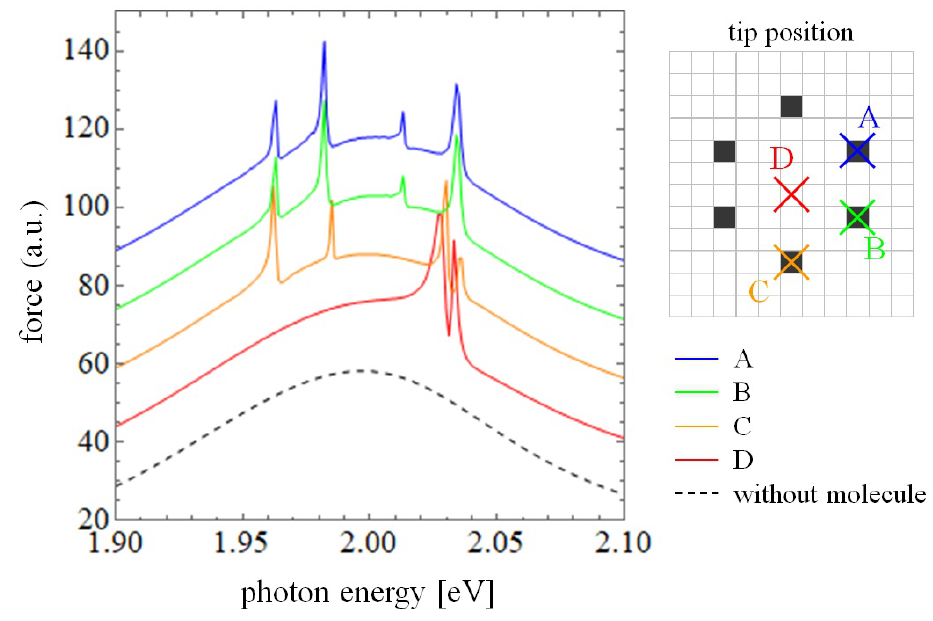
Figure 2. Photoinduced force spectra of the six-membered molecule. The solid lines are the force spectra for the respective tip positions, and the dashed line represents the force spectrum for the tip on the substrate, that is, in the absence of the